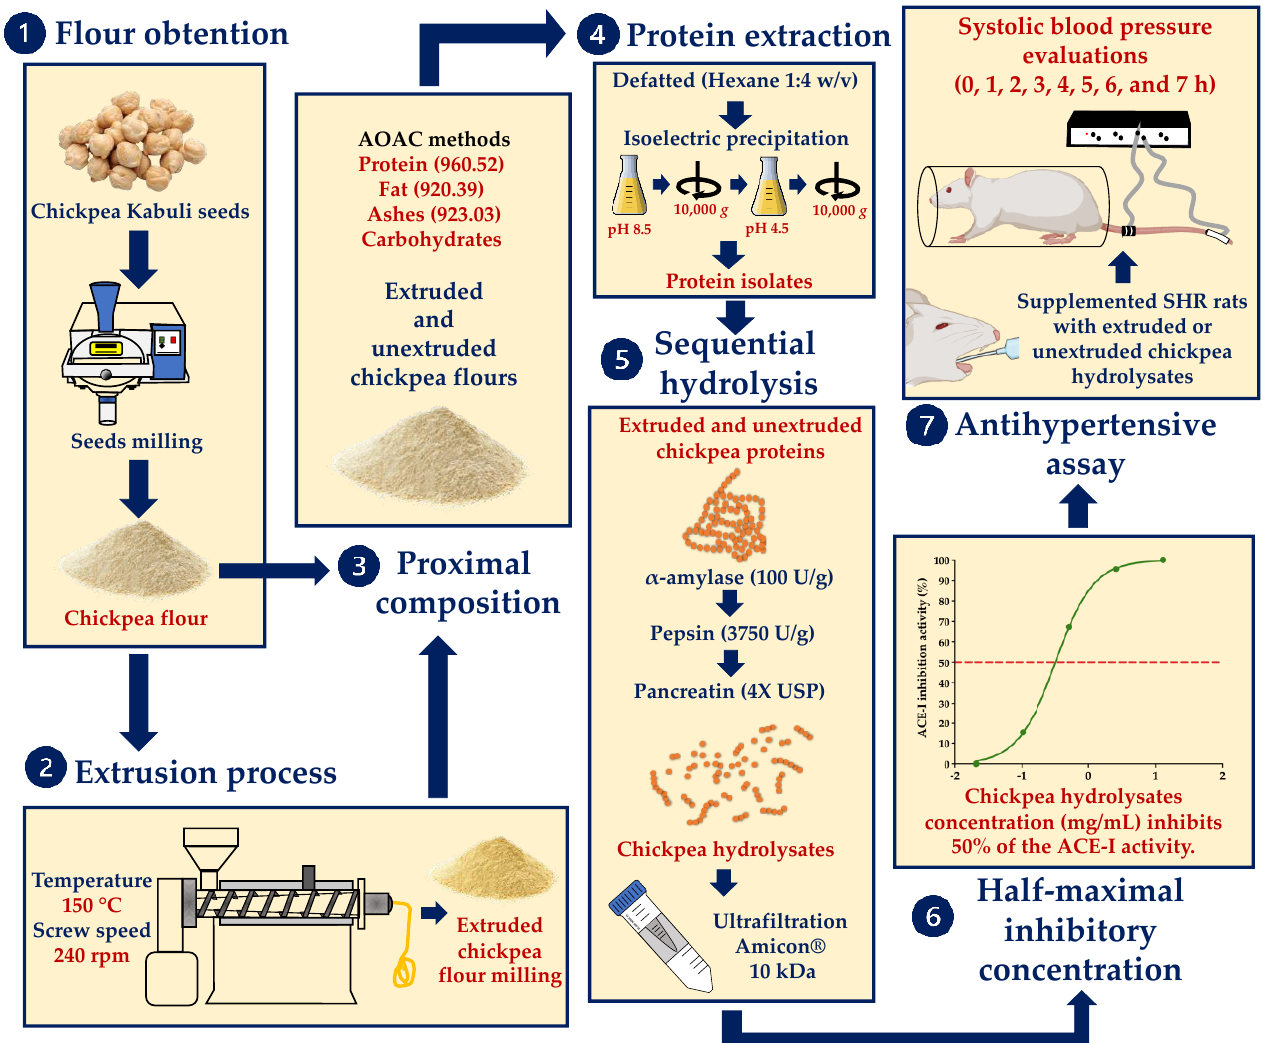
Figure 1. Workflow employed to evaluate the ACE-1 inhibition and antihypertensive effects in vivo of extruded and unextruded chickpea protein hydrolysates.